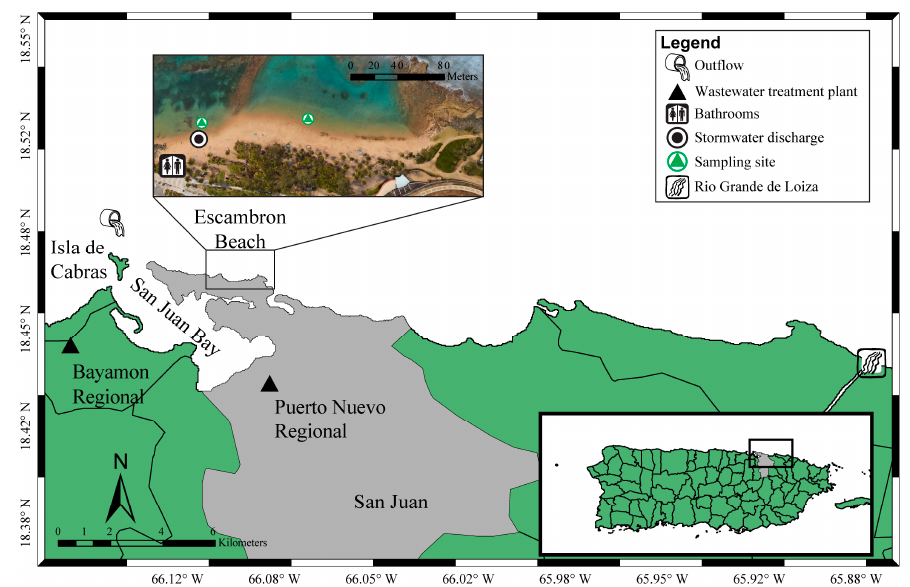
Figure 1. Location of Escambron Beach with respect to the combined ocean outfall that discharges primary-treated domestic wastewater from the Puerto Nuevo Regional and Bayamon Regional treatment plants (black triangles). The ocean outfall discharges at a depth of approximately 40 m; it is located 1 km north of Isla de Cabras and about 5 km from the study site. The inset map details Escambron Beach and depicts both sampling locations (green triangles), stormwater discharge drain (black circle), Rio Grande de Loiza (river symbol), and public bathrooms (bathroom symbol). Two sites, separated by a distance of ~100 m, were sampled by the PREQB (Figure 1). These sites may have been affected by: (1) stormwater drainage (18.46° N, 66.09° W) located immediately adjacent to one of the sampling sites, which includes urban runoff, precipitation, and other graywaters (e.g., showers, washer machines; [2]); (2) WWTP ocean outfall (18.47° N, 66.14° W); (3) beach public bathrooms; and (4) Rio Grande de Loiza, a river that receives agricultural runoff, WWTP effluent (secondary treatment only), and septic system effluent and seepage (Figure 1; [31–33]). Non-point source pollution throughout San Jan Bay also likely affects water quality at Escambron Beach.